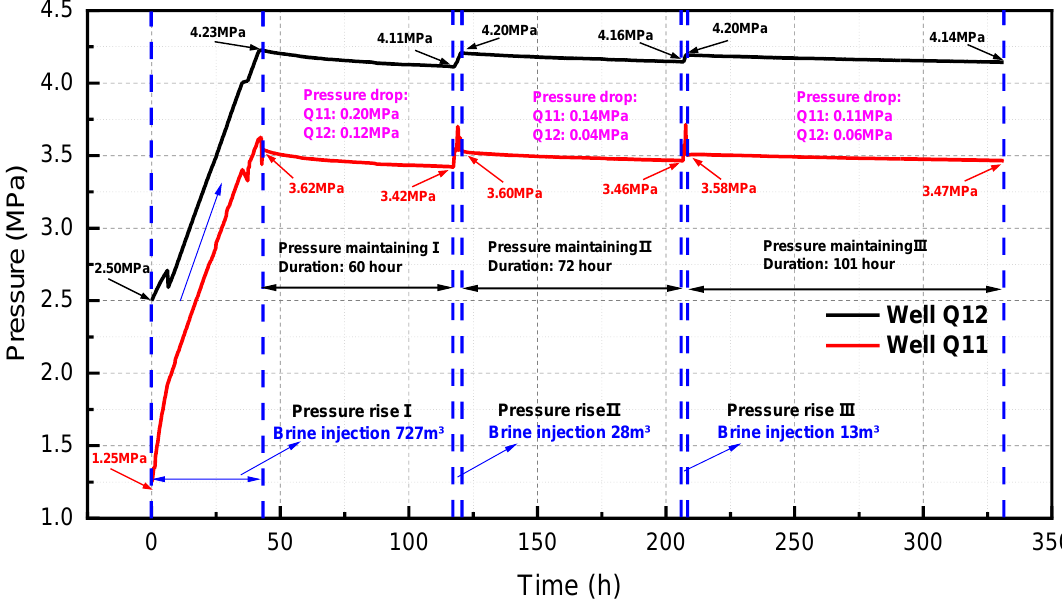
Figure 13. Pressure change curve of well Q11 – Q12 in Brine Injection Test.